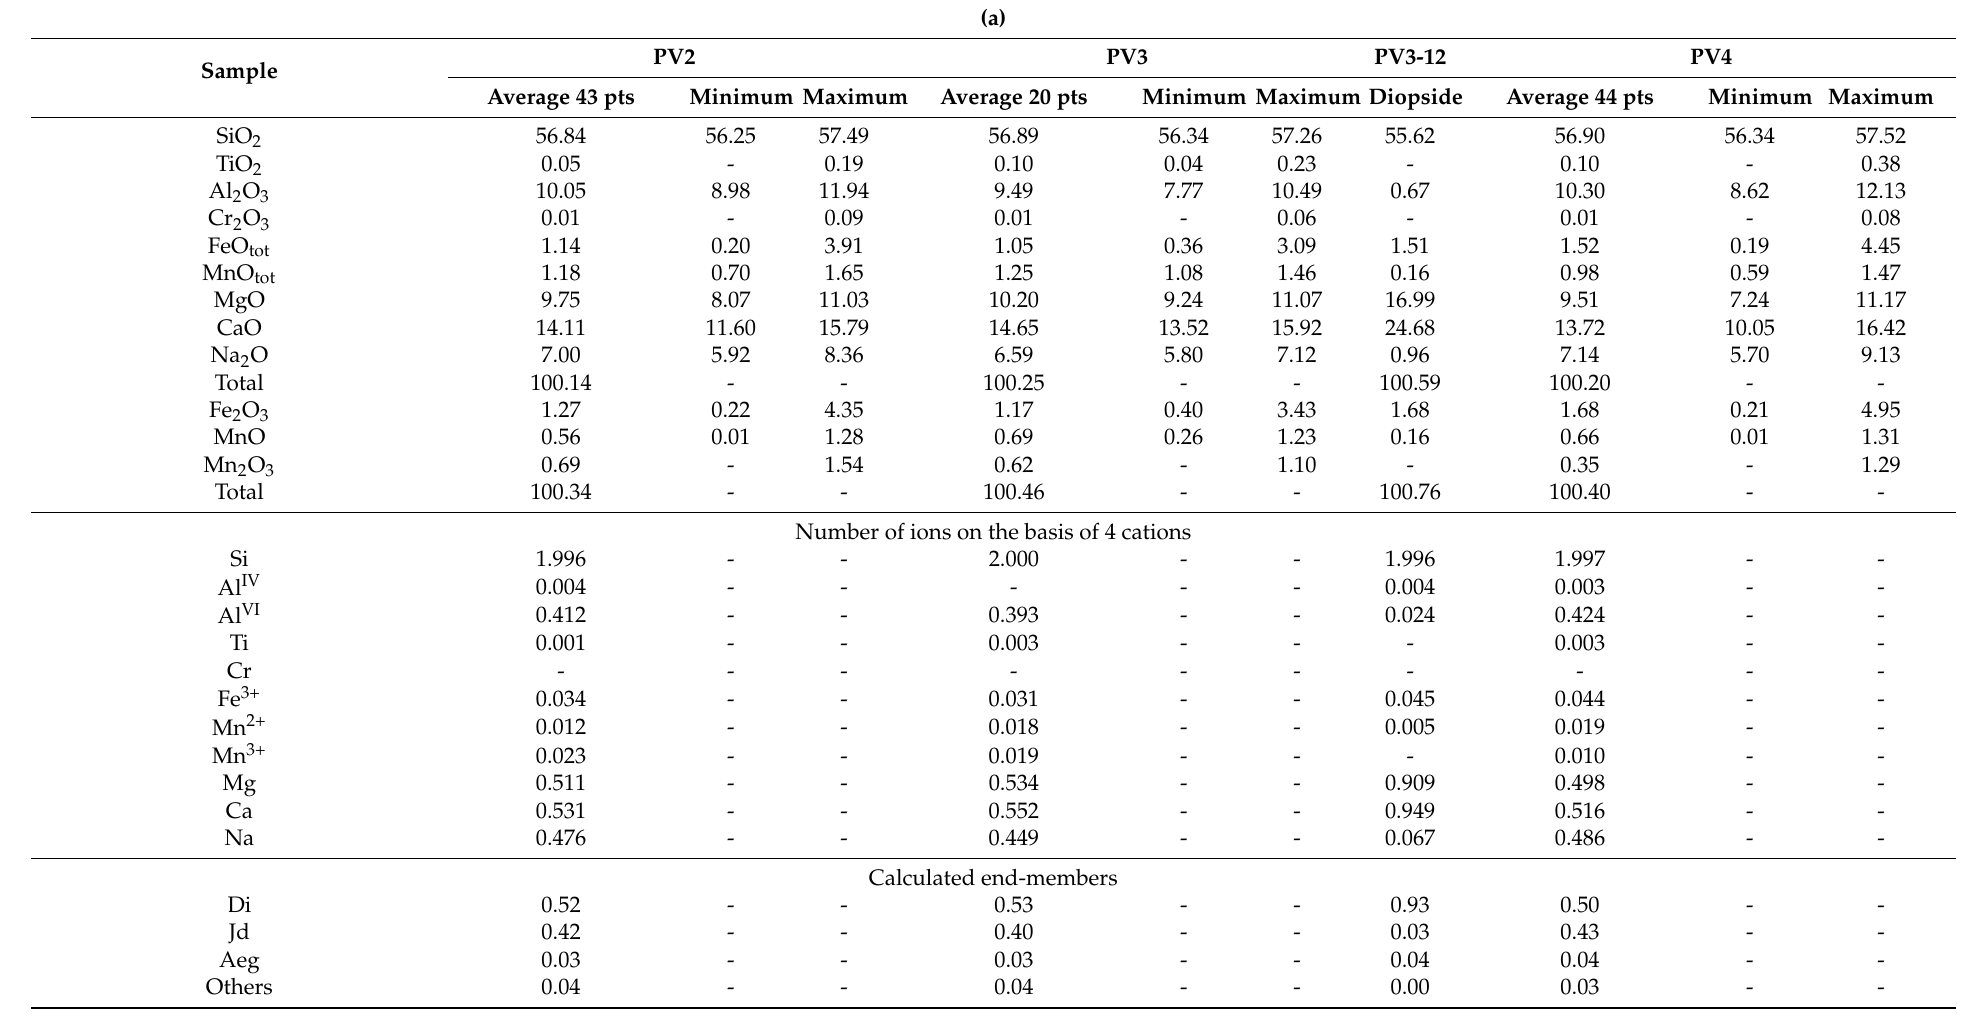
Table 2. Selected electron microprobe analyses of the violane ( a ) massive samples (PV2,3,4) and ( b ) fragments from Praborna mine, Saint Marcel (wt.